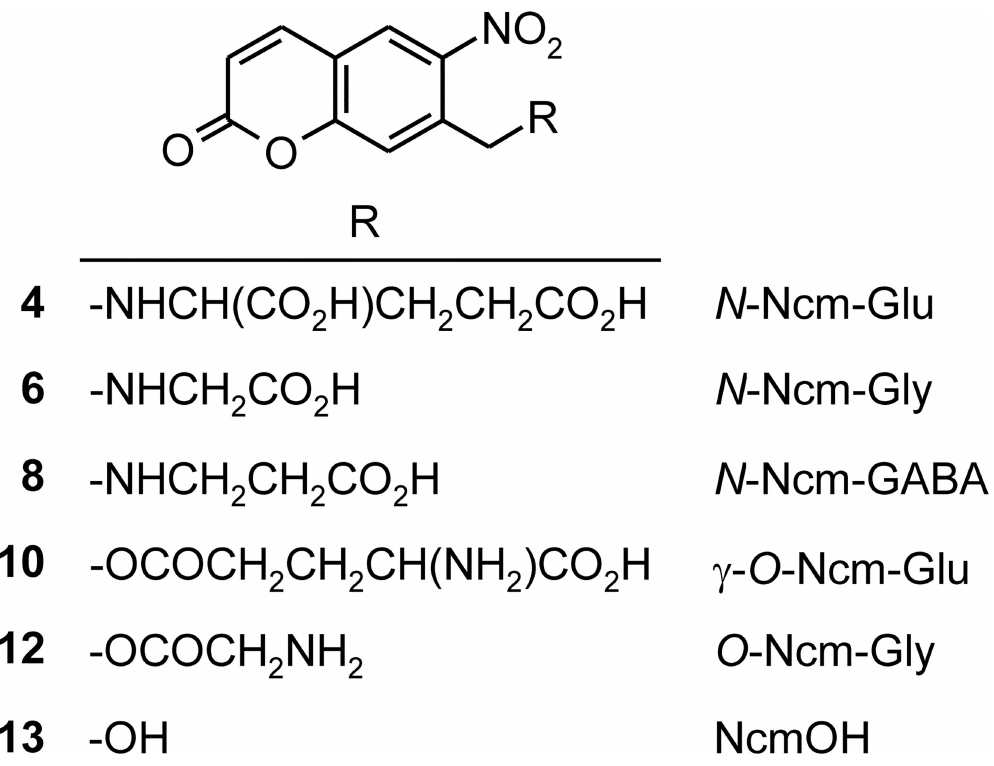
Fig 4. Summaryof Ncm